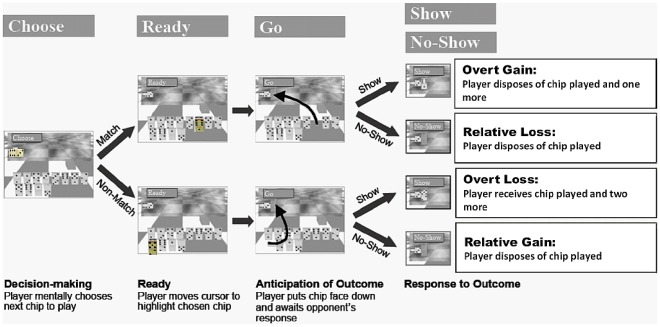
The Domino game task. The Domino game sequence and corresponding consequences are depicted.At the beginning of each round of the game the player must decide (mentally choose) what chip he/she will play next (i.e., ‘Choose’, the decision-making interval) and move the cursor to the selected chip when instructed (‘Ready’ interval). The chip can either match the opponent’s chip (i.e., have one of the two numbers on the chip match one of those on the opponent’s chip, 6∶3 in this example; upper panel, 6∶1) or not (lower panel, 5∶2). After placing the selected chip face down next to the opponent’s chip, he/she awaits the opponent’s response (‘Go’ or ‘Anticipation of Outcome’ interval). The opponent can either challenge the player’s choice (‘show’) or not (‘no-show’). Based on the player’s choice and the opponent’s response, there are four possible consequences for each round during the ‘Response to Outcome’ interval: show match (overt gain); no-show match (relative loss, as the player could have been rewarded if challenged); show non-match (overt loss) and no-show non-match (relative gain, as the player successfully “bluffed”, that is, avoided punishment). The opponent’s chip and samples of matching and non-matching chips are highlighted (in yellow) for demonstration purposes only. In the actual scan, the game board and all chips are in color, not in grayscale as depicted in the figure. Also, all chips are the same size and color.